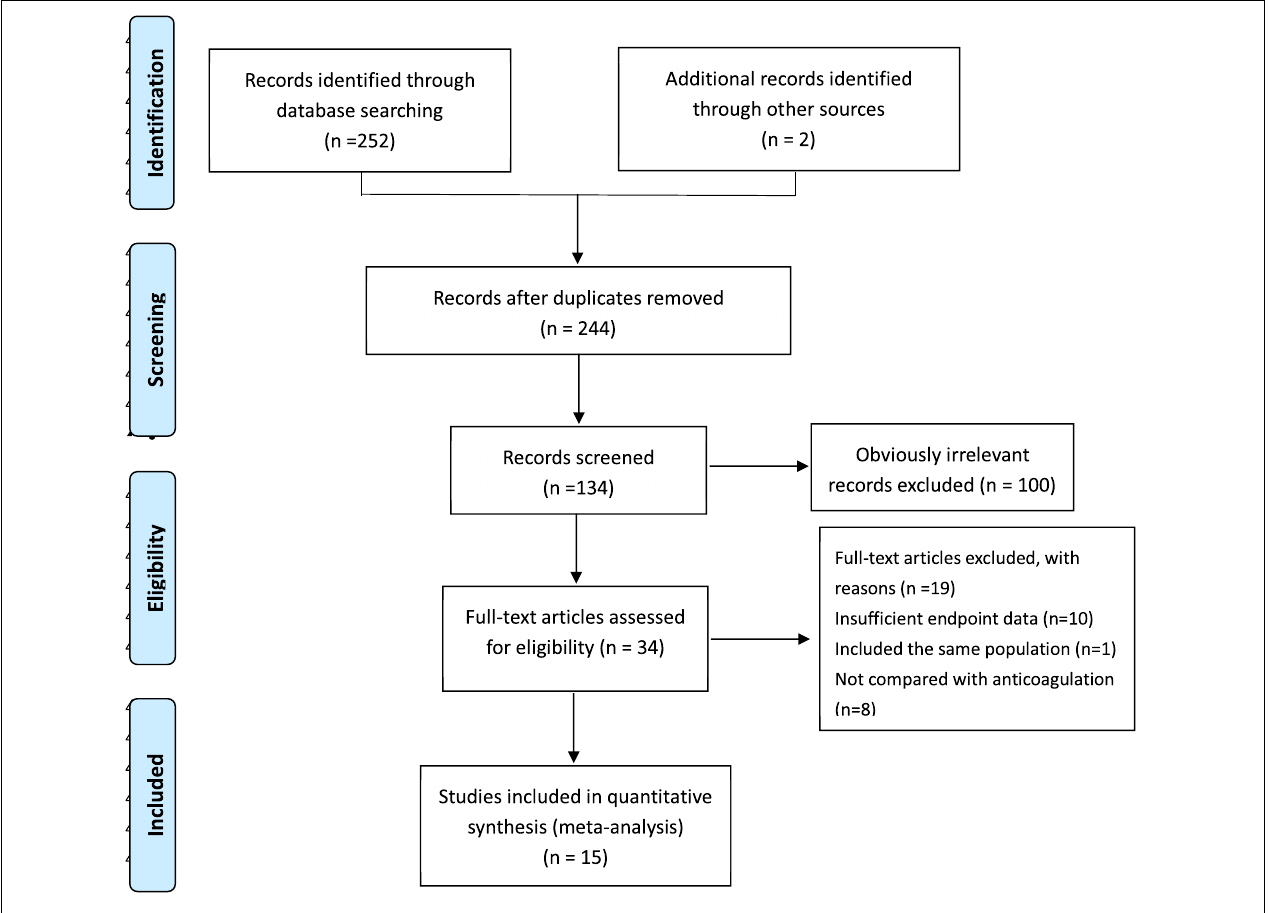
FIGURE 1 | Search strategy and study